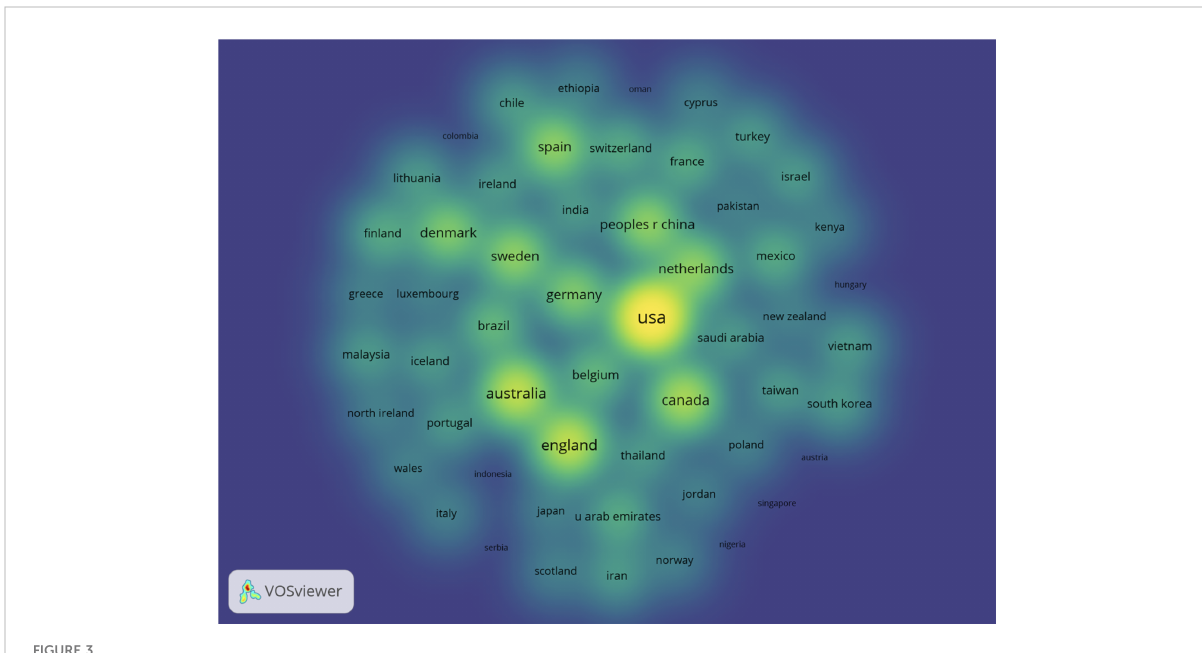
FIGURE 3 Density map of countries in